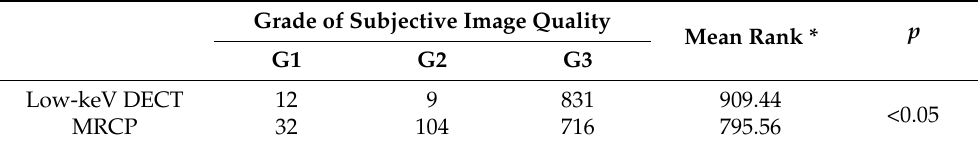
Table 4. Graded 852 patients’ images quality of low-keV DECT and MRCP according to the sharpness of the pancreatic duct